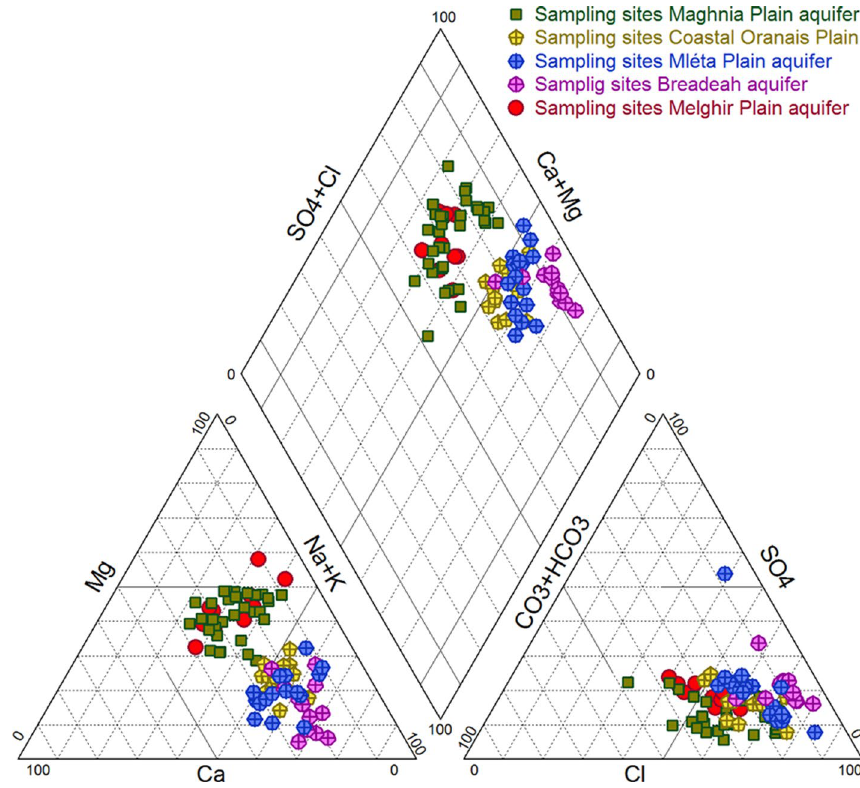
Fig. 3 Piper trilinear diagram for hydrogeochemical facies of some aquifers in the study area